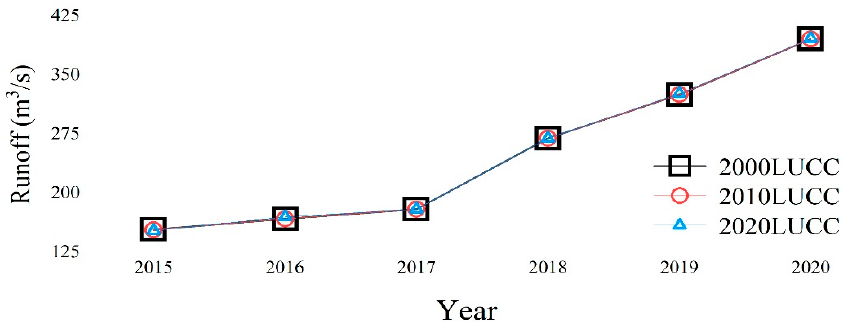
Figure 14. Annual runoff under three phases of land use.